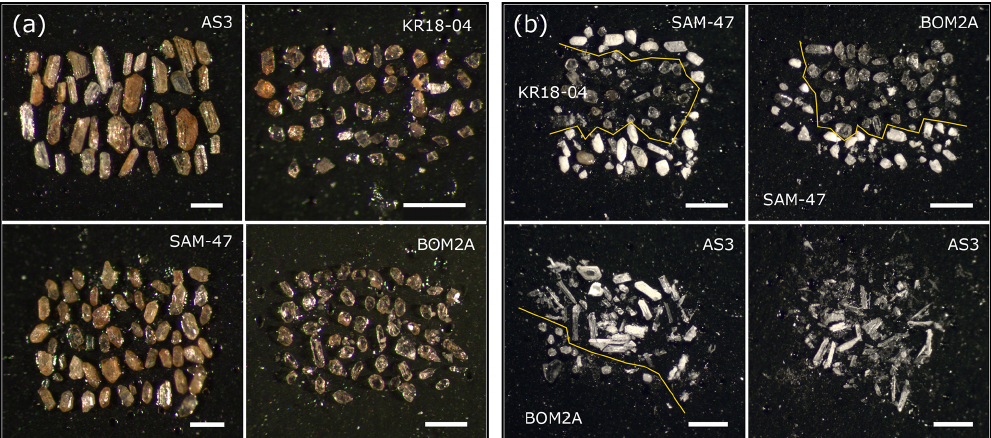
Figure 2. Color reflected-light photomicrographs of zircon crystals mounted on tape for µCT imaging. (a) Photomicrograph of annealed grains prior to chemical abrasion. (b) Photomicrograph of zircon residues following chemical abrasion. The after images illustrate how chemical abrasion anneals color centers in grains and renders grains